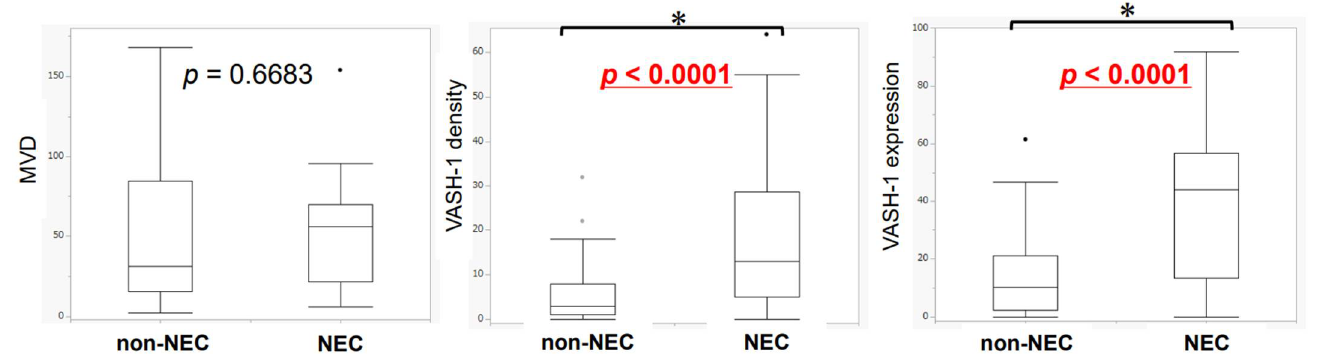
Figure 6. Difference in the number of micro-vessels expressing different markers in NEC and non- NEC components in the same case (Wilcoxon signed-rank test). The number of VASH-1-positive micro-vessels and the ratio of VASH-1 expression were significantly greater in the NEC area (VASH-1 density: p < 0.0001, VASH-1 expression: p <0.0001). There were no significant differences in the MVD (MVD: p = 0.6683). The points are outliers. * it: intra-tumoral, im: invasive margin. MVD, micro-vessel